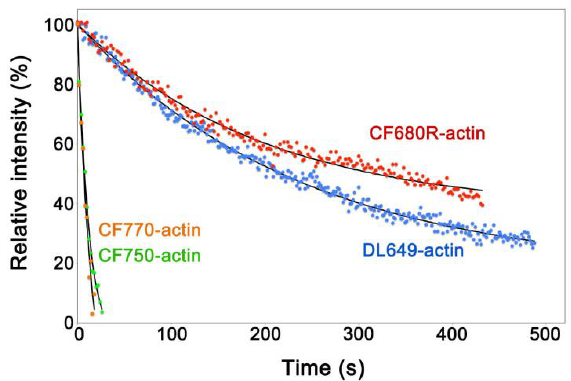
Figure 1. Intracellular photostability of fluorescent dye-labeled actin probes. XTC cells loaded with each fluorescent dye-labeled actin by electroporation were continuously exposed to excitation light using the 100 W mercury illumination system. The single-molecule speckle (SiMS) of each actin probe was acquired with 2 s exposure time without interval. The excitation light used was full for CF750- (green dots) and CF770-actin (orange dots), attenuated to 25% for DL649-actin (blue dots) or 12% for CF680R-actin (red dots). The filter sets used were the Cy5 filter set (Semrock: Rochester, NY, USA) for DL649-actin, the Cy5.5-C filter set (Semrock) for CF680R-actin and the IRDYE 800 filter set (Semrock) for CF750- and CF770-actin. Black lines show the single-exponential curve fitted to the data. Relative intensity ( y- axis) shows percentages derived from the fluorescence intensity of the peripheral region of the XTC cell divided by the value at the y- intercept of the fitted curve. The data shown are representative of at least two independent experiments.